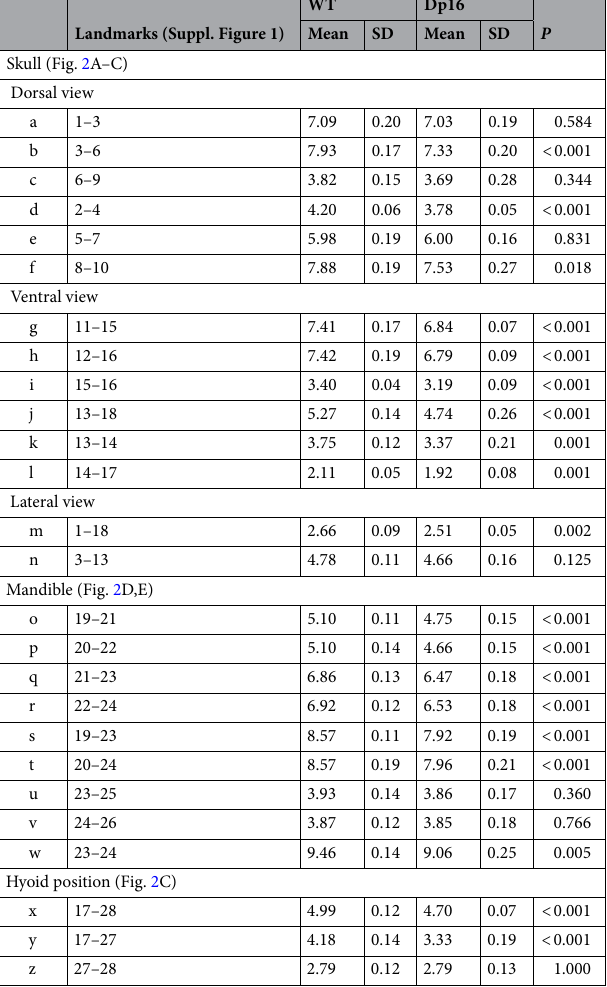
Table 2. Craniofacial measurements between WT and Dp16 mice. The unit is